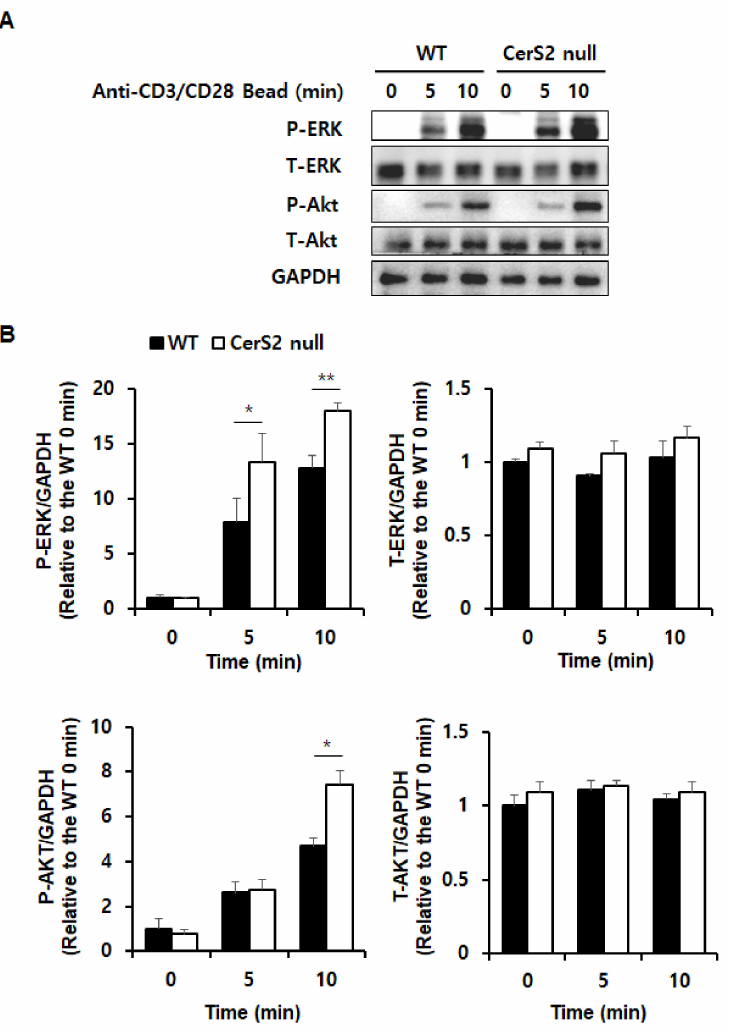
Figure 6. Wild type (WT)-CD4+ T cells and CerS2 null-CD4+ T cells differ in T cell receptor signal strength during T cell receptor stimulation. ( A ) Splenic CD4+ T cells from WT and CerS2 null mice were stimulated with anti-CD3/CD28 beads for 5 and 10 min, followed by western blotting to detect phosphorylated ERK, total ERK, phosphorylated AKT, and total AKT. Glyceraldehyde 3-phosphate dehydrogenase (GAPDH) was used as an internal control. ( B ) The pixel density of each protein band was divided by that of GAPDH for normalization. Data are expressed as the mean ± SEM ( n = 3). * p < 0.05; ** p < 0.01. The representative images are shown of three independent experiments. Statistical significance was analyzed using the two-way analysis of